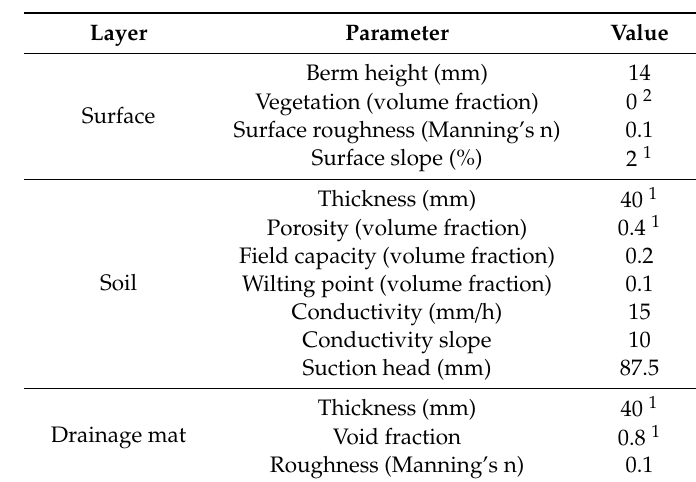
Table 1. Parameters of the calibrated green roof model.